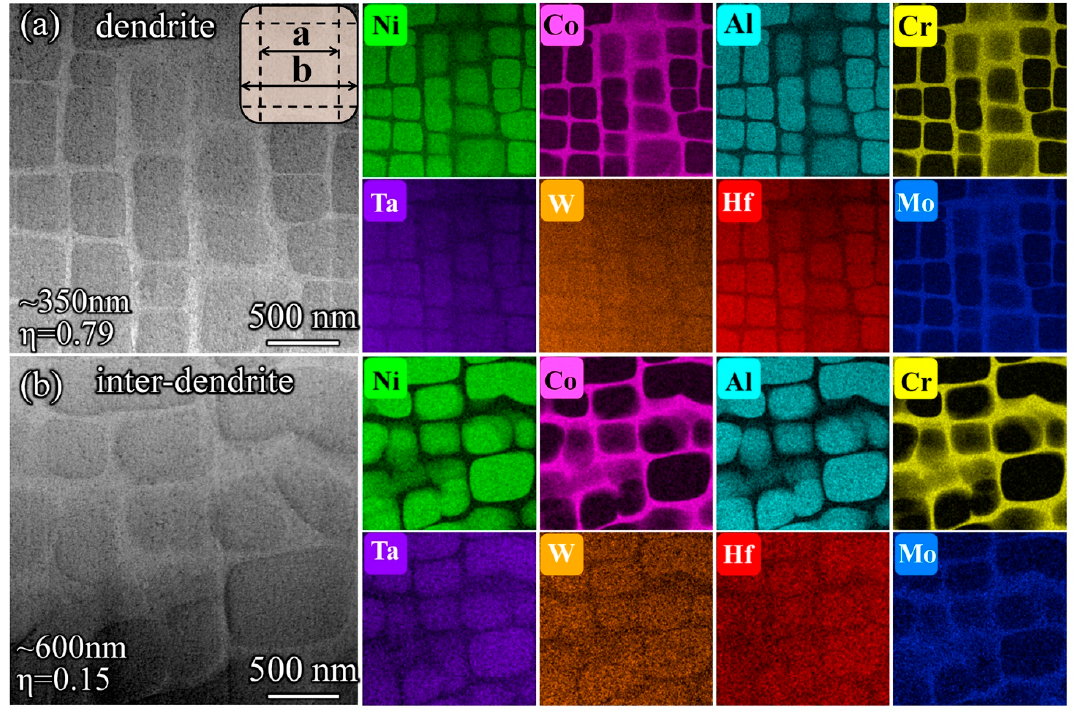
Figure 2. The γ′ - γ microstructure in the dendritic stem and inter-dendrite of the shank. ( a , b ) HAADF images and elemental distributions of dendritic stem and inter-dendrite. The attached figure is a schematic diagram of the calculation of the shape factor, and the γ′ phase size and form factor are labeled.